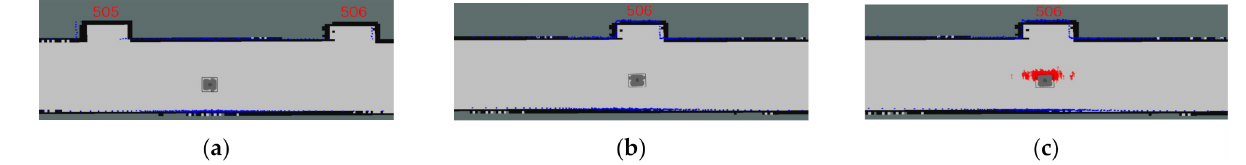
Figure 11. Global localization using our proposed Text-MCL method. ( a ) Initial state of the robot; ( b ) Moving to a doorway area; ( c ) Initialize the particles after text